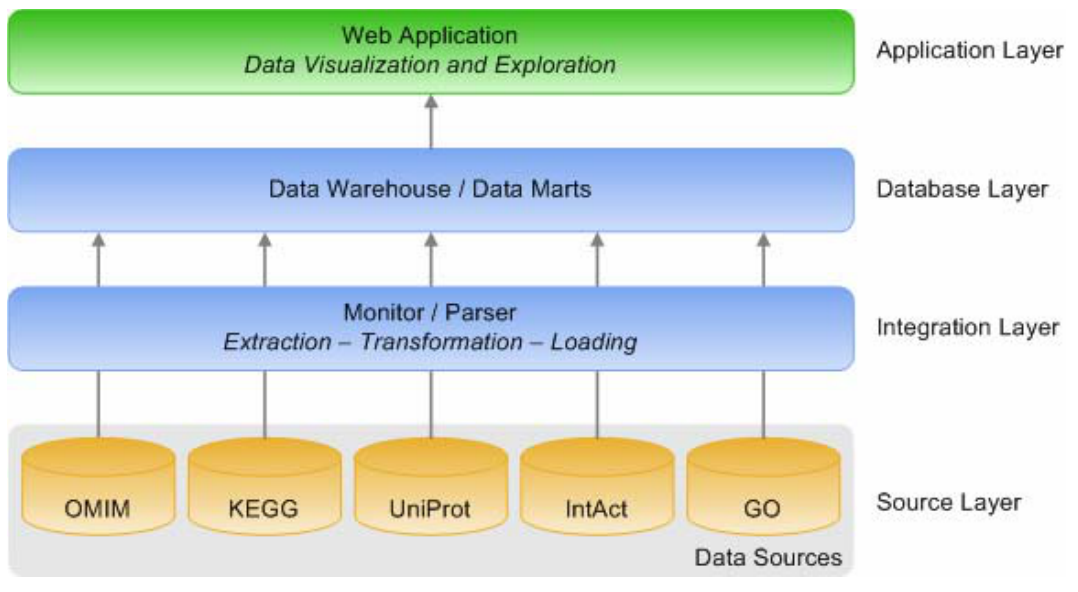
Figure 1: Schematic representation of the VINEdb 4-layer system architecture and the flow of data from the original heterogeneous data sources in the source layer to the web